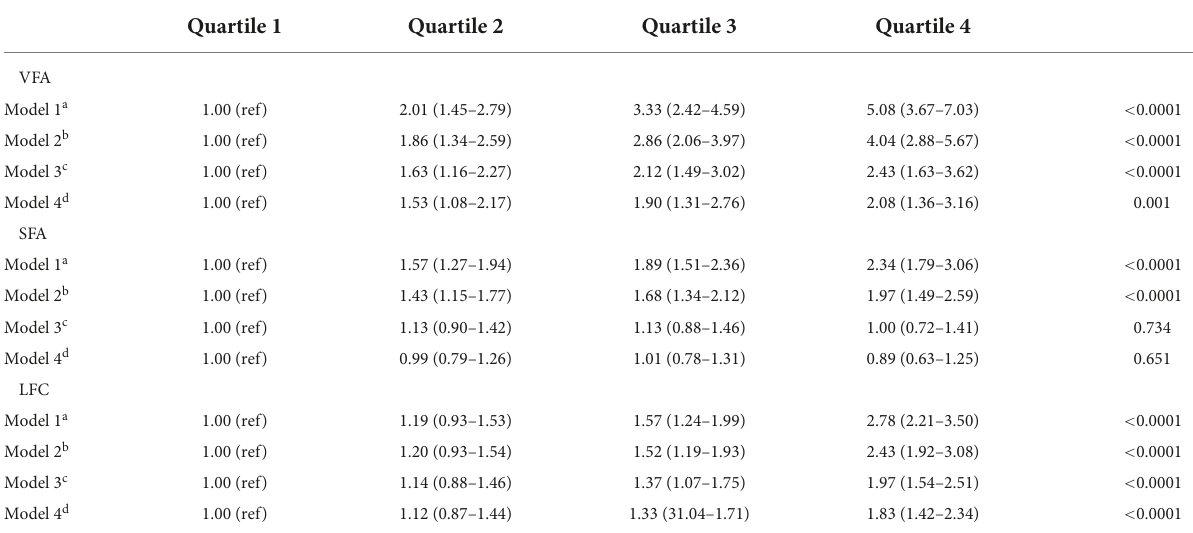
TABLE 2 Association between adipose variables and hyperuricemia prevalence ( N = 3,683). Quartiles of adipose variables P for trend* Quartile 1 Quartile 2 Quartile 3 Quartile